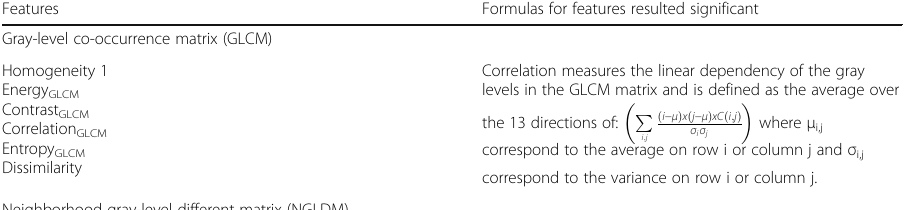
Table 1 Texture features calculated from the [ 18 F]FDG-PET/CT images in Lifex to characterize thyroid incidentalomas